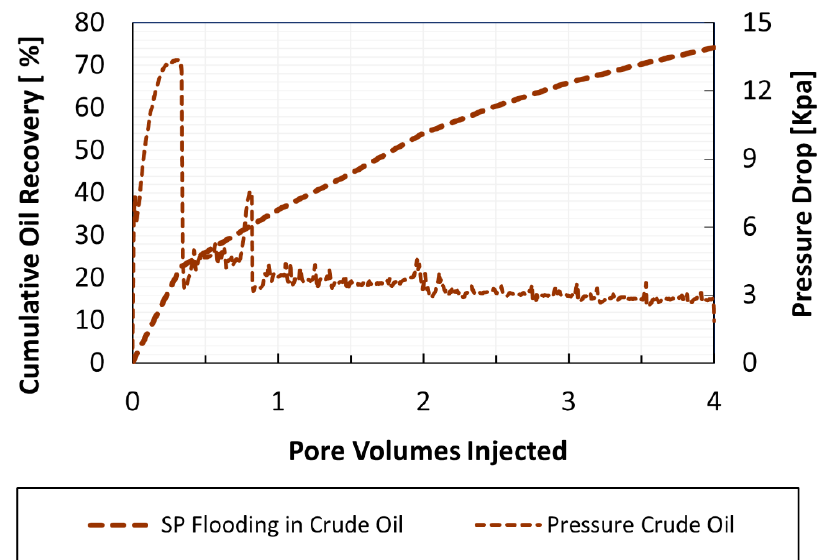
Figure 13. Oil recovery by SP flooding for crude oil.